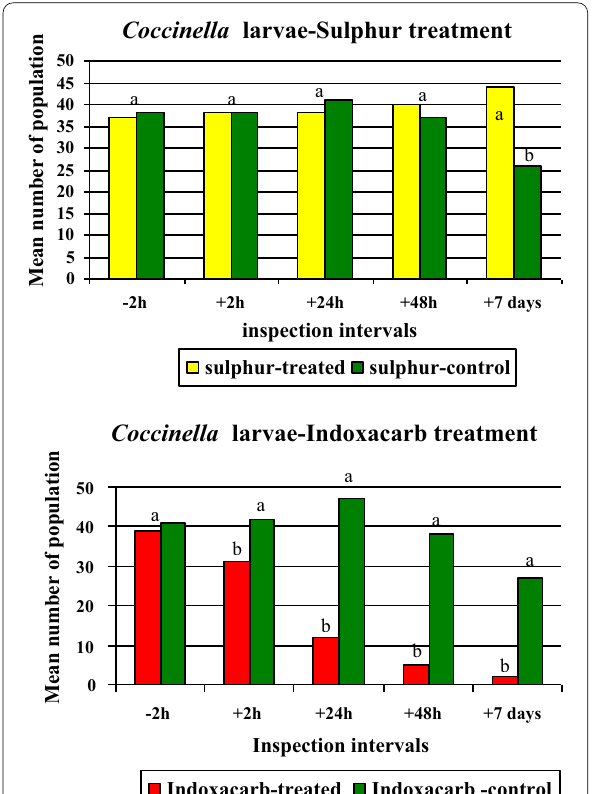
Fig. 1 Effect of indoxacarb and sorell 98% applications on the abundance of Coccinella larvae. Significant differences were calculated separately for each interval